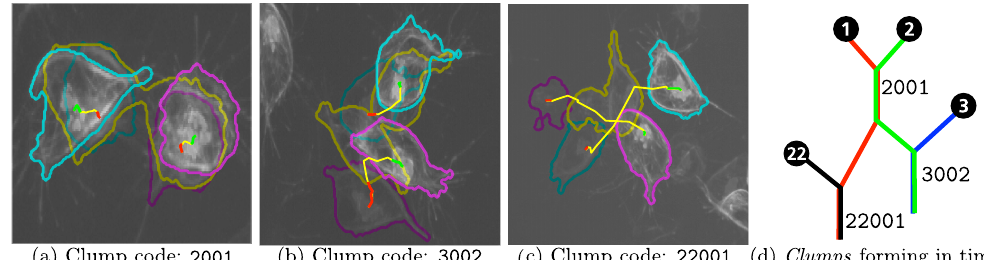
Figure 8. Frames in different interactions overlapped to appreciate cell movement and clump formation. ( a – c ) Three frames are superimposed: the first, middle, and final frames in each experiment are shown, with corresponding segmentations and tracks. The full track in each experiment is presented, with changes of colour representing different moments: before (red), during (yellow), and after (green) the clump . ( d ) is a representation of the same cells forming different clumps at different time points.